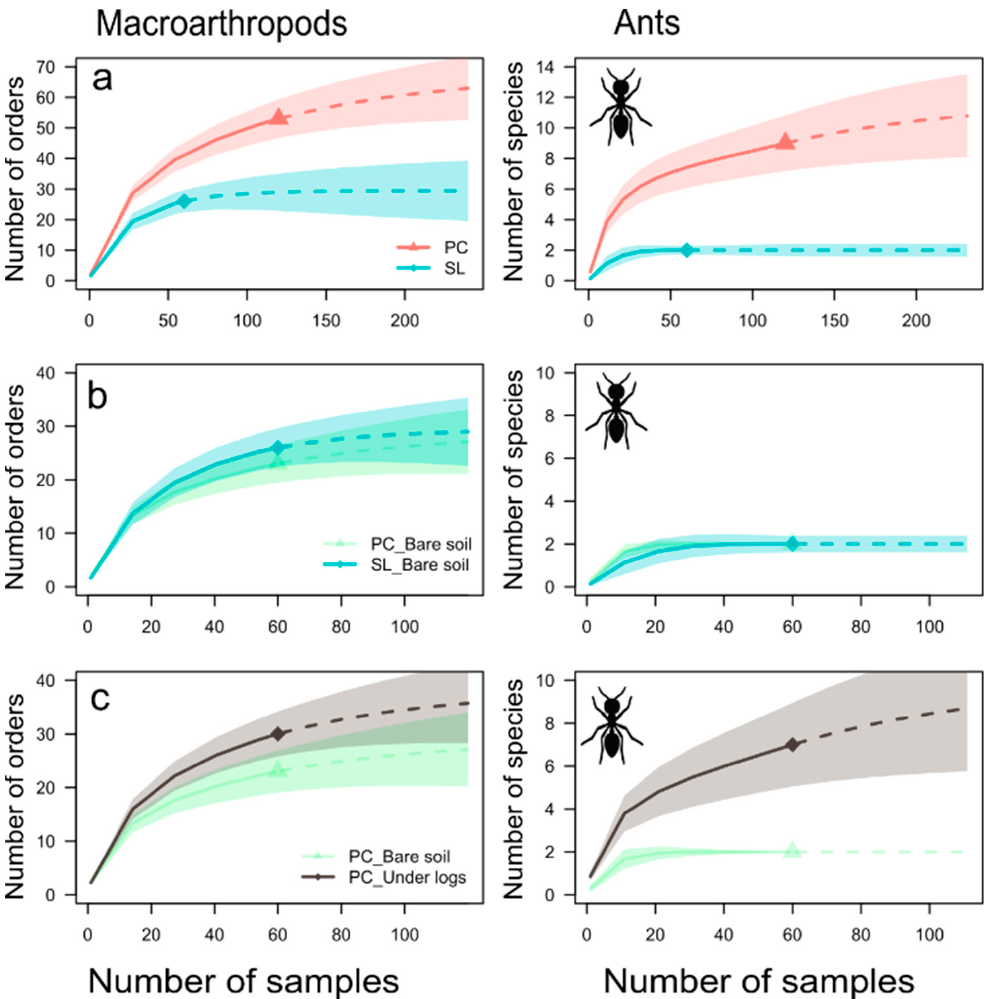
Figure 2. Sample-based rarefaction (solid lines) and extrapolation (dotted lines) until reaching twice the maximum sample size for macroarthropod orders and ant species at the Low Plot. Shaded areas represent 95% confidence intervals. The lettering of the panels indicates the three hypotheses of this study: di ff erences between ( a ) dead-wood treatments, ( b ) treatments under the bare-soil microhabitat only, and ( c ) microhabitats in the PC treatment. Curves for the High Plot are shown in the supplementary Figure A1. Dead-wood treatments are SL = Salvage logging and PC = Partial Cut.